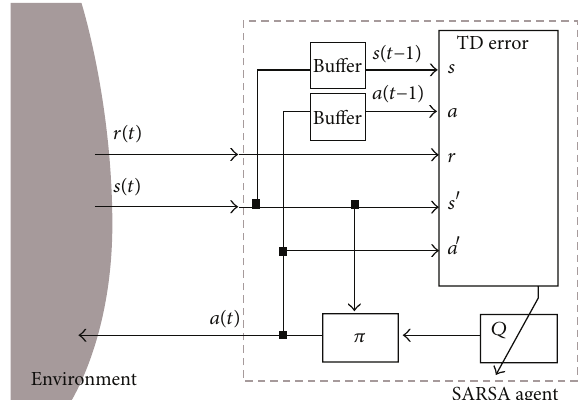
Figure 1: SARSA agent and interacting variables (this figure is adapted from Figure 6.15 of Sutton and Barto